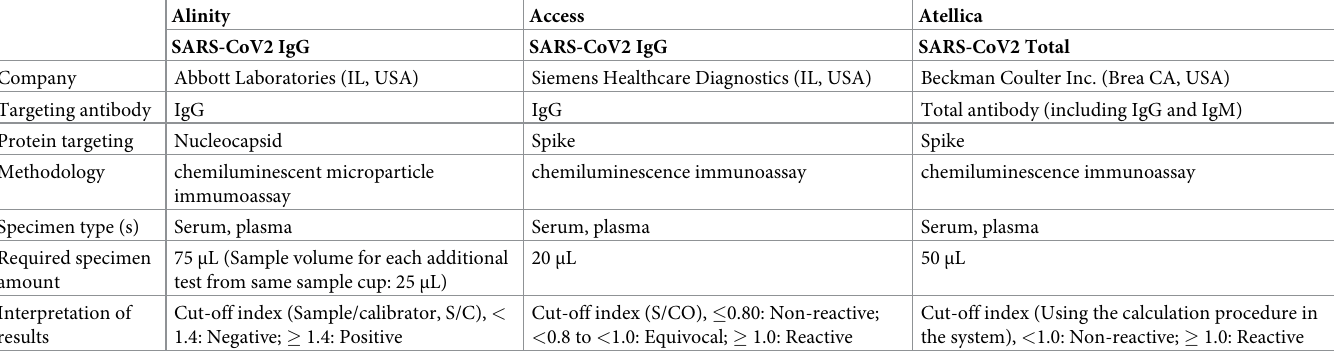
Table 1. Information on three chemiluminescence immunoassay used for testing antibody of COVID-19.